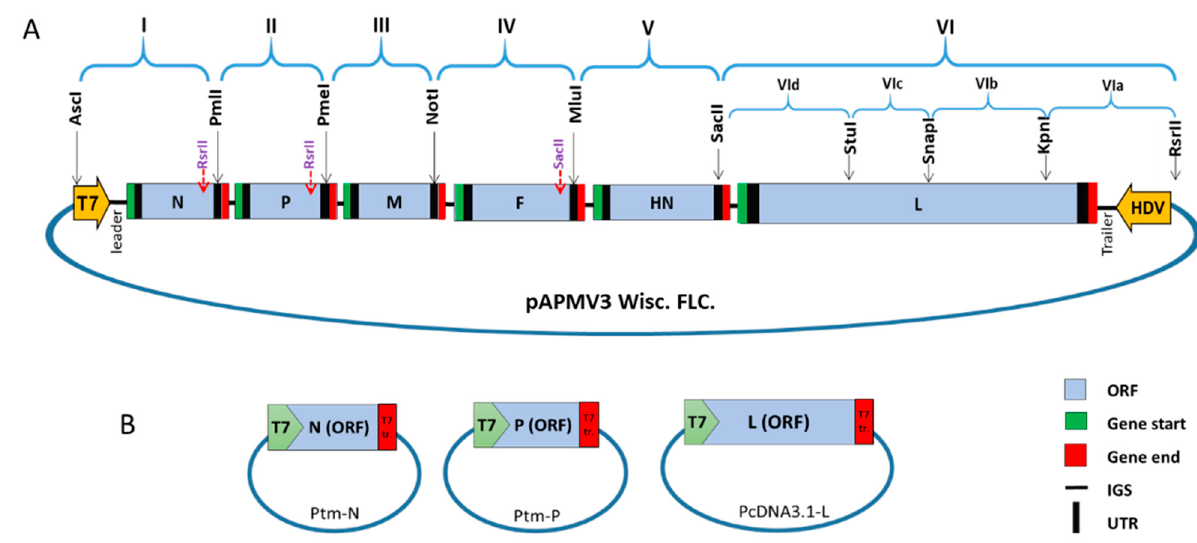
Figure 1. Construction of avian paramyxovirus 3 strain Wisconsin full-length expression plasmid (pAPMV-3 Wisc.) full- length clone (FLC) cDNA and its support plasmids ( A ) The full-length cDNA clone was constructed by assembling six sub-genomic fragments into pBR 322/dr using a 116 nucleotide long oligonucleotide linker to form an antigenomic full- length cDNA clone (pAPMV-3 Wisc.). ( B ) Three support plasmids were constructed by individually cloning the N, P, and L genes into T7 polymerase expression plasmids (pTM for the N and P genes and pCDNA 3.1 for the L gene).